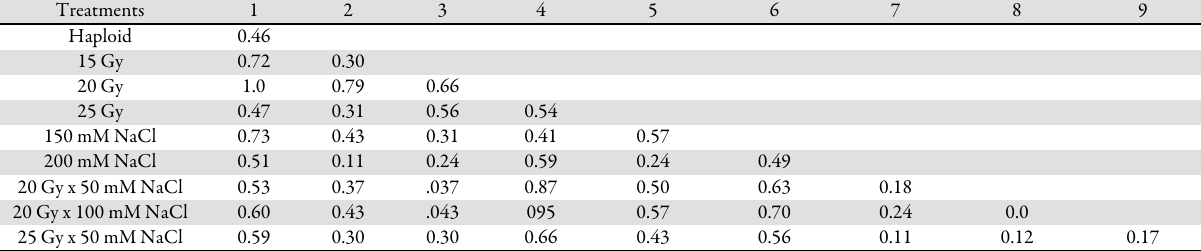
Table 6. Similarity index (pairwise comparison) among the ten treatments based on RAPD analysis Treatments